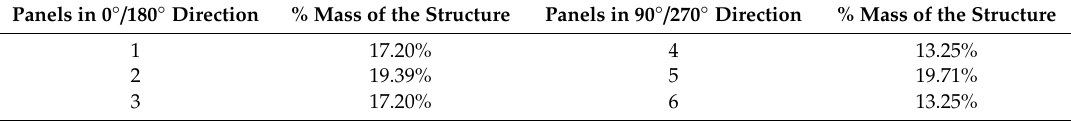
Figure 20. ( a ) Panels in the 0 ◦ / 180 ◦ direction (Figure 19); ( b ) Panels in the 90 ◦ / 270 ◦ direction (Figure 19) [34]. Table 12. Mass distribution along the shear panels illustrated in Figure 20